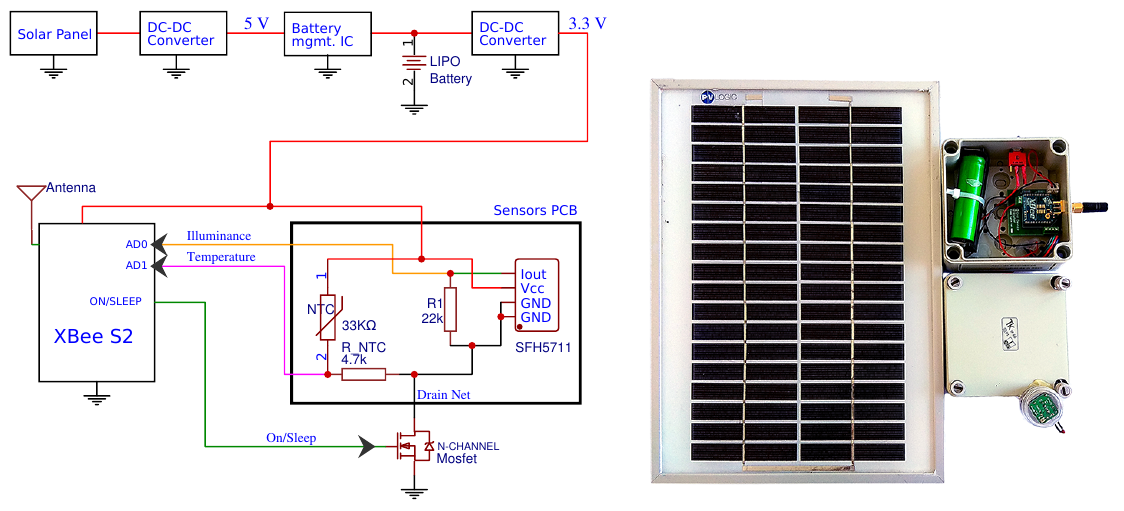
Figure 1. Mote schematics ( left ); and hardware prototype ( right